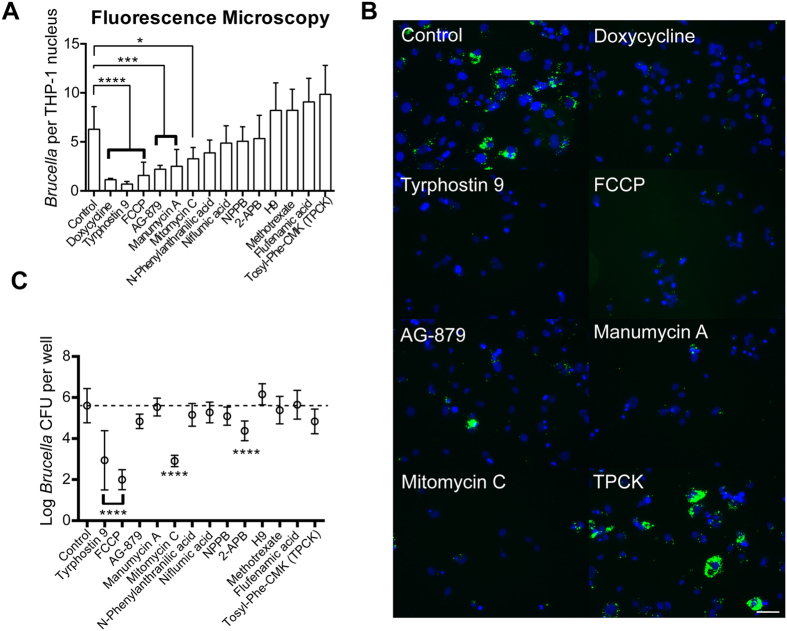
Efficacy of non-cytotoxic pathogen-targeting compounds as inhibitors of B. abortus intracellular replication in a THP-1 infection model. (A) Quantification of inhibitory efficacy of compounds, measuring the average ratio of bacteria-to-nucleus in THP-1 cells treated with each of the 13 non-cytotoxic pathogen-targeting compounds in a single experiment. Statistical significance was evaluated from ≈7 images per treatment using one-way ANOVA followed by Dunnett’s test (*p < 0.05, ***p < 0.001, ****p < 0.0001). Error bars represent +/− standard deviation. (B) Sample fluorescence images of nuclei (blue) and intracellular B. abortus (pseudocolor green) assessing the efficacy of each of the 5 final pathogen-targeting compounds that significantly inhibited infection by B. abortus: tyrphostin 9, FCCP, AG-879, manumycin A, and mitomycin C. Doxycycline is a positive control and TPCK represents a non-hit compound that did not have any effect on infection. Scale bar = 50 μm. (C) B. abortus CFU counts generated from infected THP-1 treated with 13 identified non-toxic compounds that inhibit B. abortus metabolism in axenic culture. Data represent an average from 3–7 biological replicates. Error bars represent +/− SEM.